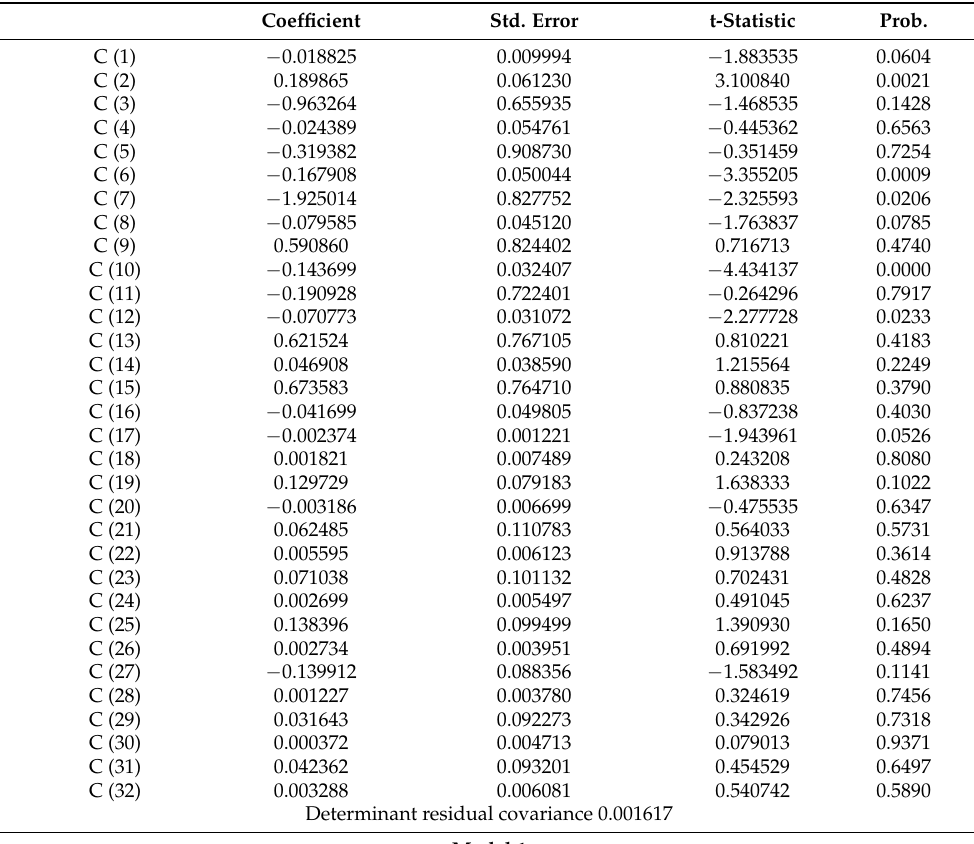
Table 7. Ordinary least square (OLS)